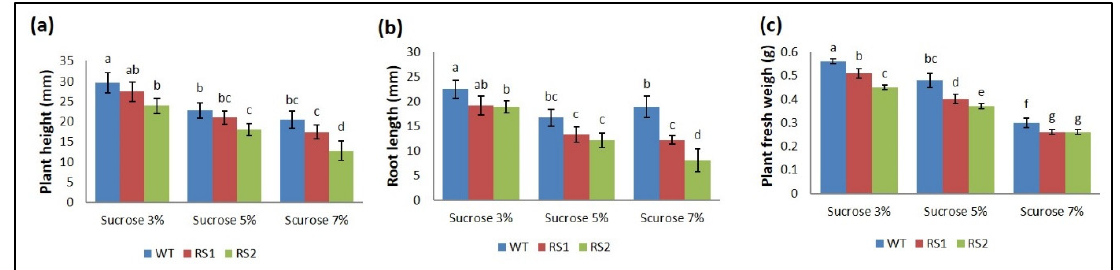
Figure 4. Effect of sucrose on growth attributes (( a ); plant height, ( b ); root length, ( c ); plant fresh weight) in wild type (WT) plants and transgenic torenia overexpressing RsMYB1 . Data are presented as the means of three replicates. Error bars indicate standard error. Groups annotated with the same letter are not significantly different by Duncan Multiple Range Test (DMRT, p < 0.05).